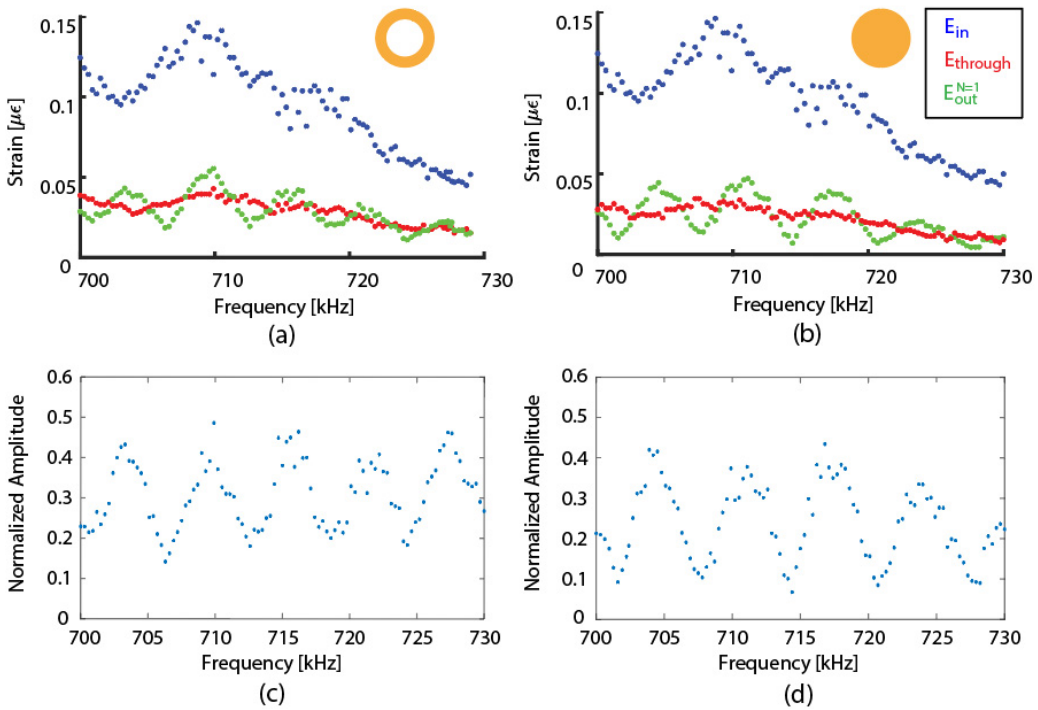
Figure 5. Wave interference pattern from 700 kHz to 730 kHz for: ( a ) a 75- μ m hollow-core fiber ring and ( b ) a standard single-mode fiber ring, and normalized wave interference pattern from 700 kHz